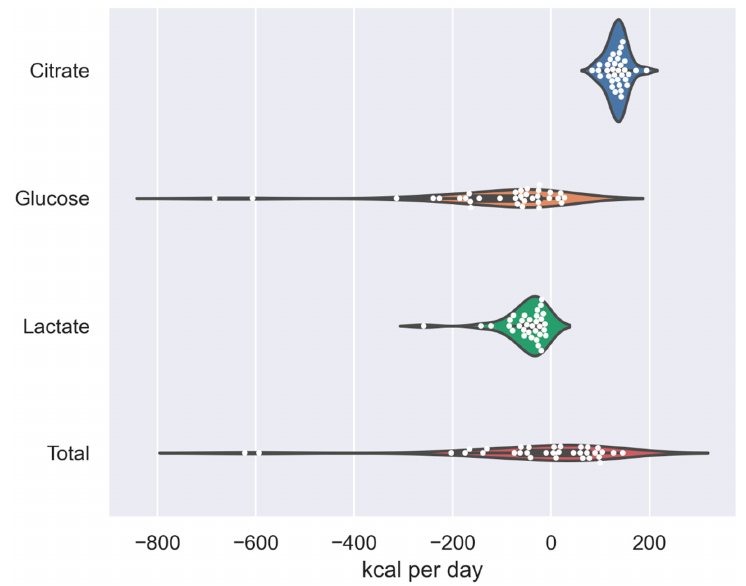
Figure 2. Violin plot of caloric balances of the three macronutrients (citrate, glucose, lactate) and total calorie balance. Median lactate levels in prefilter blood (19 mg/dL, IQR: 13–33 mg/dL) and effluent (19 mg/dL, IQR 13–31 mg/dL) showed no relevant difference from each other and blood lactate concentration was a very strong predictor for effluent lactate concentration in the linear regression model (R 2 = 0.98, p < 0.001, Figure 3). Figure 3. Linear regression models with 95% confidence intervals of prefilter lactate and lactate in effluent, prefilter glucose and glucose in effluent, and calculated citrate per plasma and citrate in effluent, respectively. 3.3. Glucose Caloric Balance